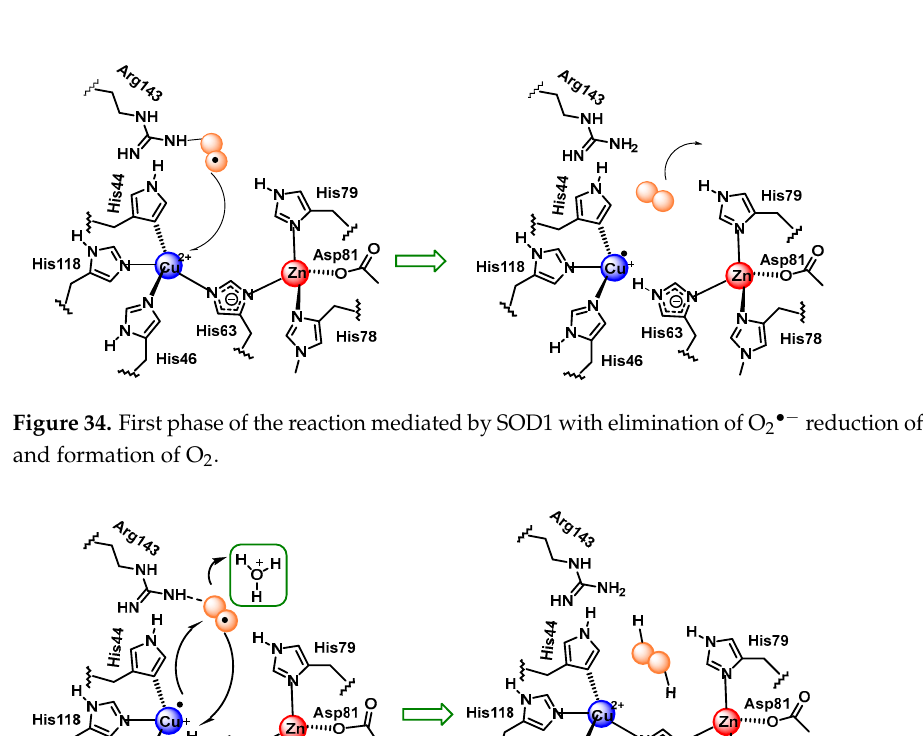
Figure 35. Second part of the reaction mediated by SOD1, transformation of the second O 2•– into hydrogen peroxide and regeneration of the catalytic centre.